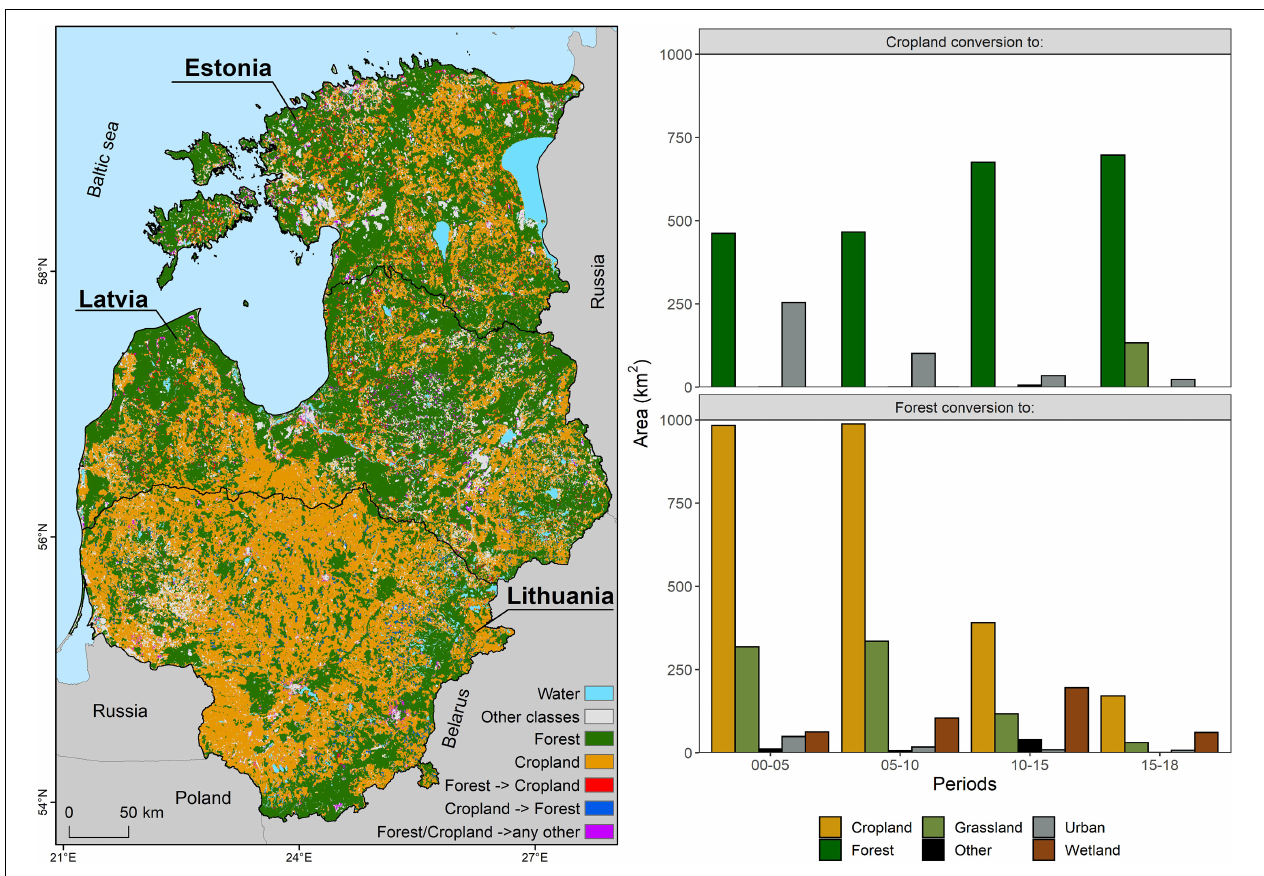
FIGURE 1 | Changes in the areas of forest and cropland in the Baltic countries from 2000 to